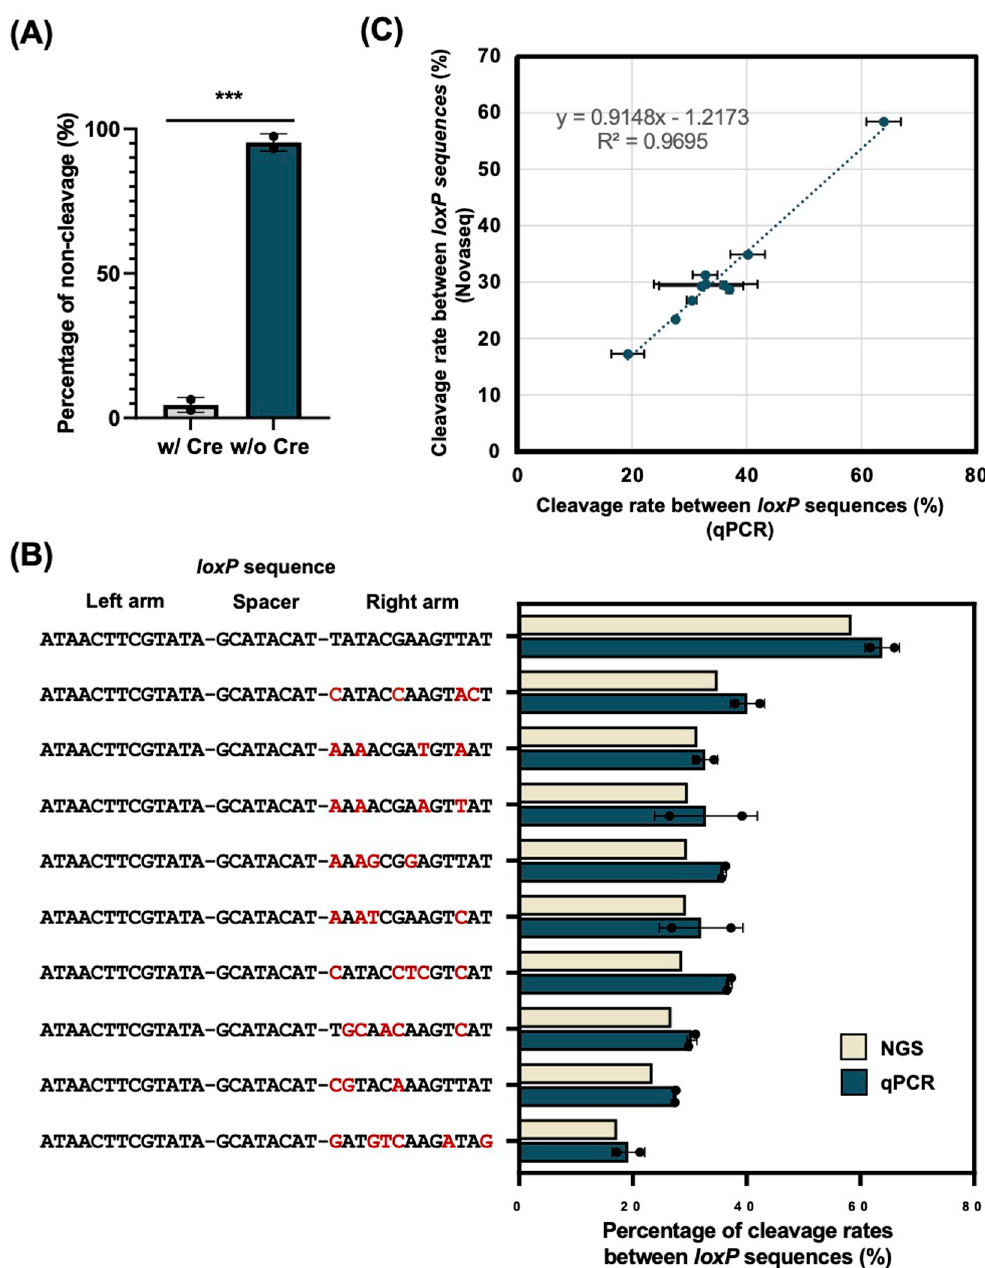
Fig 6. Quantification of the cleavage rate of loxP variants by qPCR. (A) Comparison of non-cleavage rates in the presence or absence of Cre induction. The error bars represent the standard deviation. A significant difference was found in the presence or absence of Cre induction (two-tailed t -test, N = 3). ��� P < 0.001 (B) Comparison of the results of the Illumina sequencing analysis and qPCR. We randomly selected nine loxP variants and the WT loxP sequence for qPCR. We quantified the cleavage rate of the loxP sequence in each variant and WT (see details in the Materials and Methods). The mutated nucleotide is shown in red. The bar graph in light yellow shows the cleavage rate of loxP sequences quantified by Illumina sequencing, whereas green indicates the results of qPCR. Each plot was averaged across two independent experiments. The error bars represent the standard deviation. (C) Correlation of the cleavage rate between loxP sequences, as quantified by Illumina sequencing analysis and qPCR. Each plot was averaged across two independent experiments. The error bars represent the standard deviation.